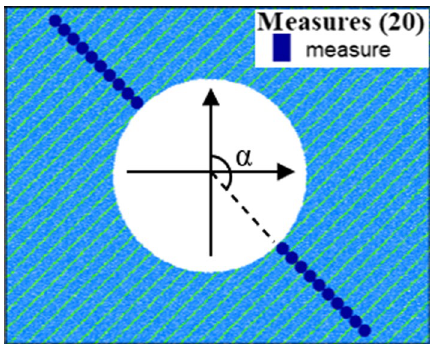
Fig. 7 Arrangement of measuring points